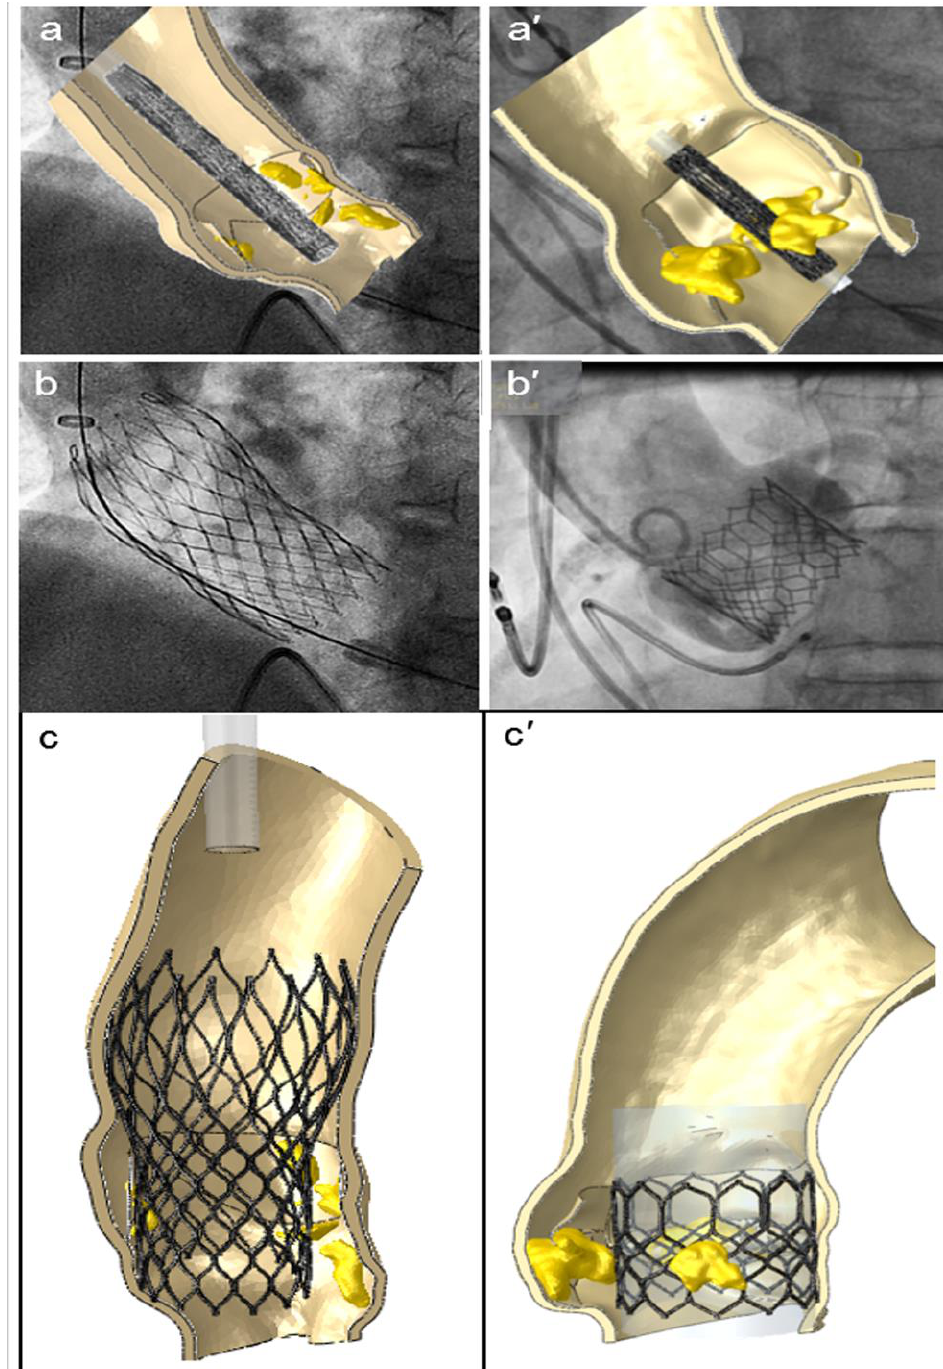
Figure 3. FEA simulations of TAVR in two investigated patients who showed postoperative thrombosis. The positioning ( a , a′ ) and reopening ( c , c′ ) of CoreValve and Sapien devices (left and right sides, respectively), compared to the corresponding intraoperative angiographic images ( b , b′ ).